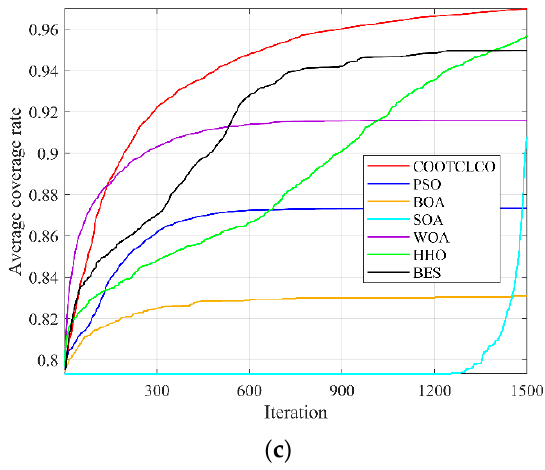
26 of 33 Table 10. Comparison of average coverage rate Algorithm